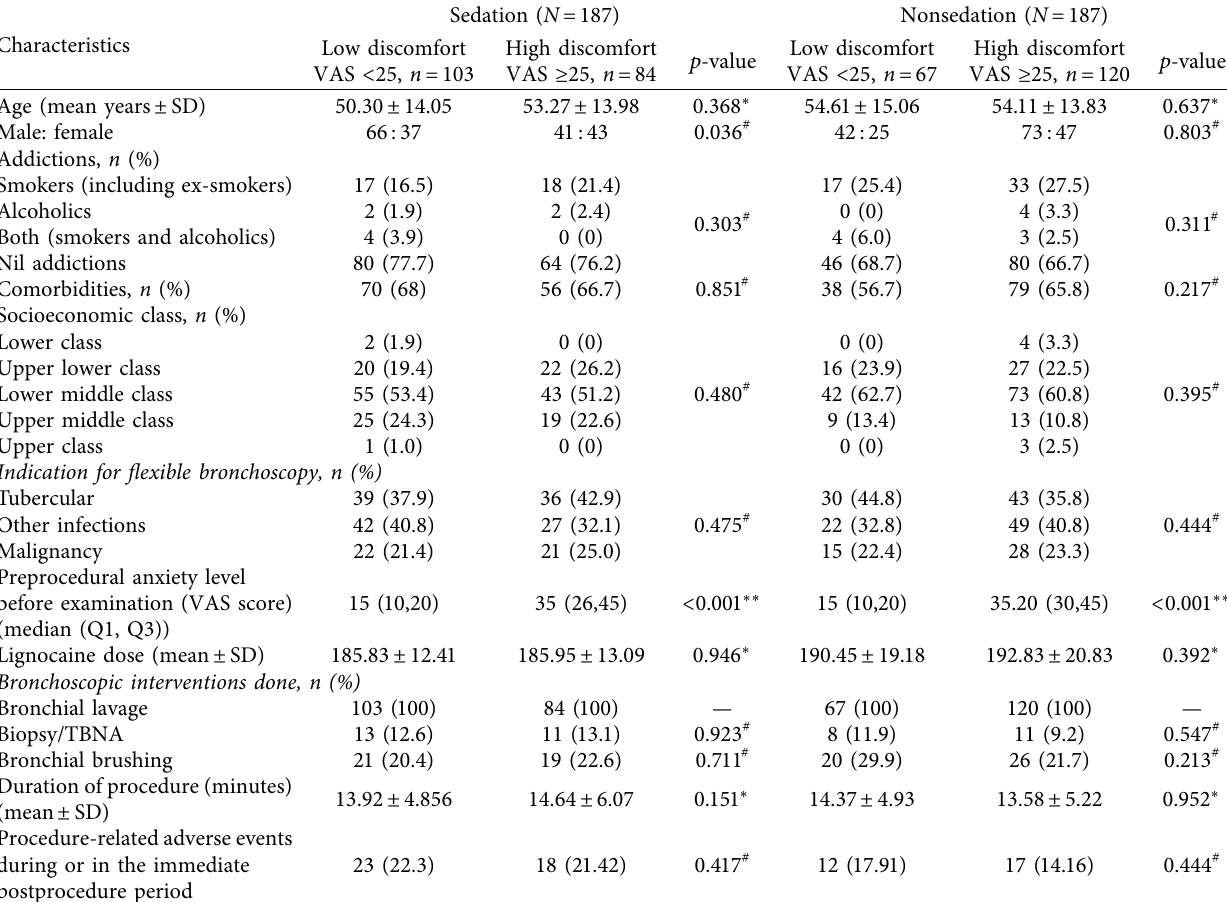
Table 4: Factors affecting patient comfort in sedation and nonsedation groups during flexible bronchoscopy.